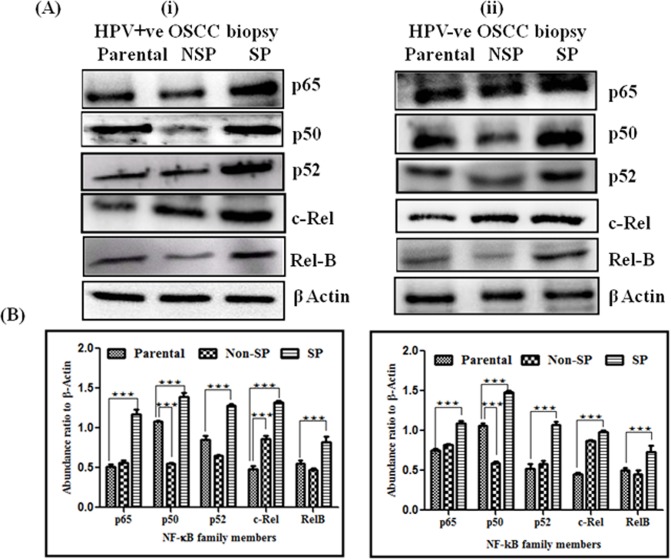
Differential expression pattern of NF-κB family proteins in OSCC biopsies.A. Western blot analysis of NF-κB family proteins in cellular protein extracted from sorted SP, NSP and parental cells from (i) HPV+ve OSCC biopsies and (ii) HPV-ve OSCC biopsies. A total of 25 μg protein extracts each from SP, NSP and parental cells were separated on a 10% SDS-PAGE, electrotransferred on PVDF membrane and probed for NF-κB family proteins p65, p50, p52, c-Rel and Rel-B. To confirm equal protein loading, the membranes were reprobed for β-actin expression. The relative normalized fold change in the protein is expressed as the mean ±SD of three independent experiments. B. Bar diagram showing NF-κB family proteins expression between SP cells, NSP cells and Parental cells from (i) HPV+ve OSCC biopsies and (ii) HPV-ve OSCC biopsies. ***P value <0.001, **P value <0.01, *P value <0.05.